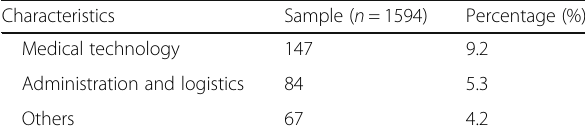
Table 1 Demographic characteristics of the sample